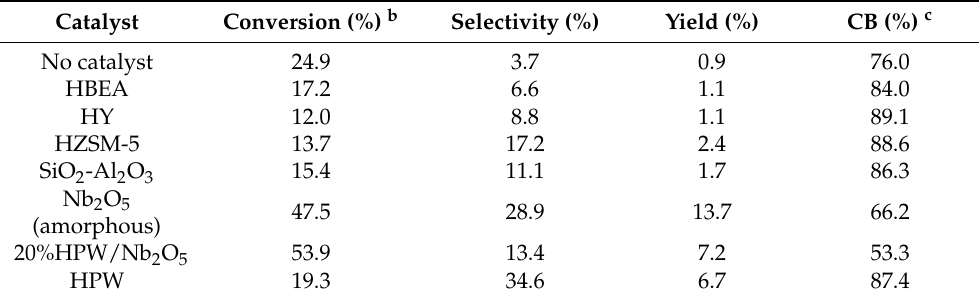
Table 1. Conversion (fructose), selectivity and yield (HMF) for the different catalysts in aqueous solution a